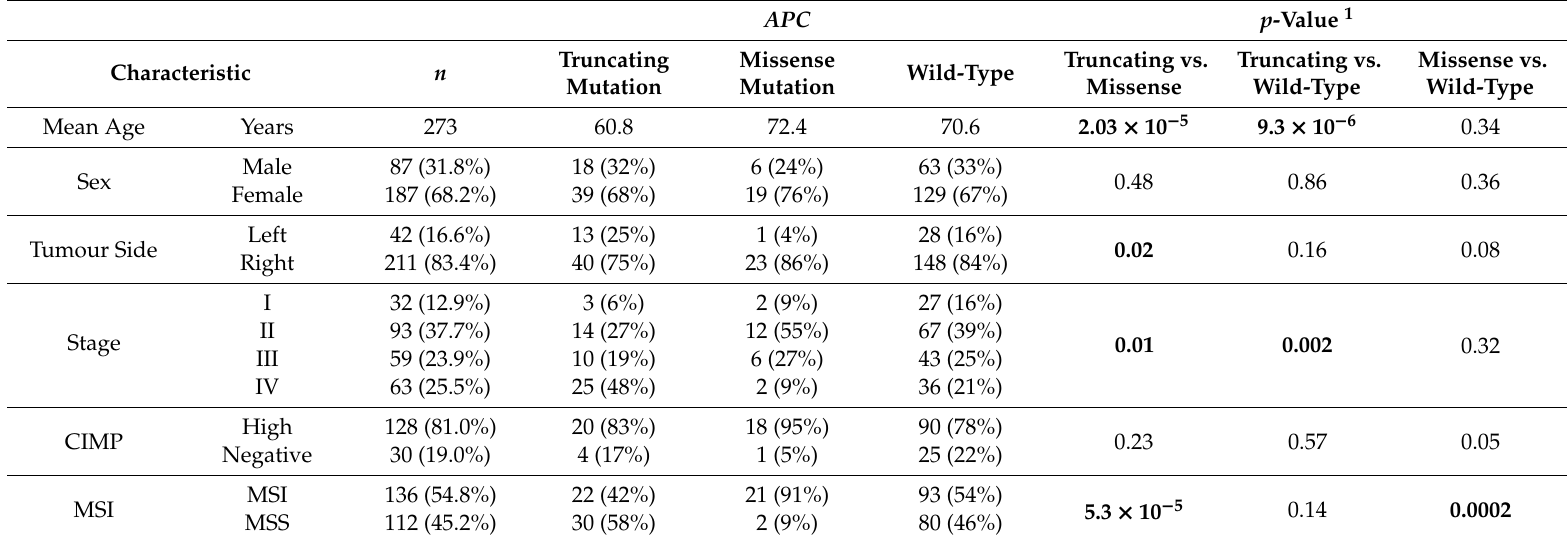
Table 4. Clinical and molecular characteristics of BRAF mutant cancers with APC mutation.